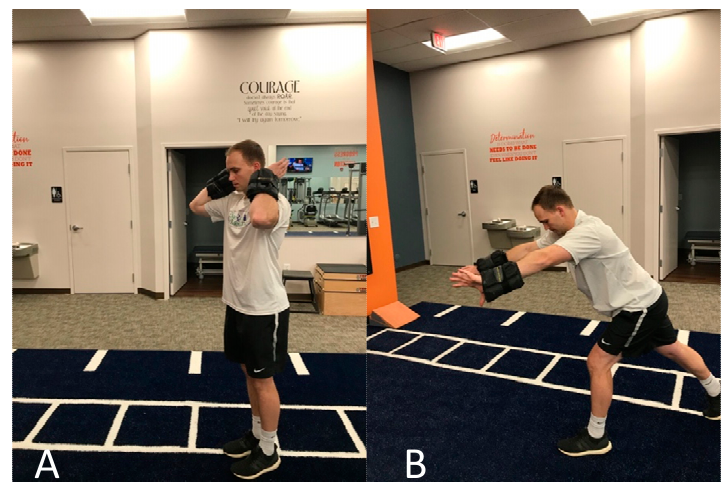
Figure 4. Plyometric medicine ball throw against wall. ( A ) Starting in wind-up position, ( B ) deceleration phase after ball release.